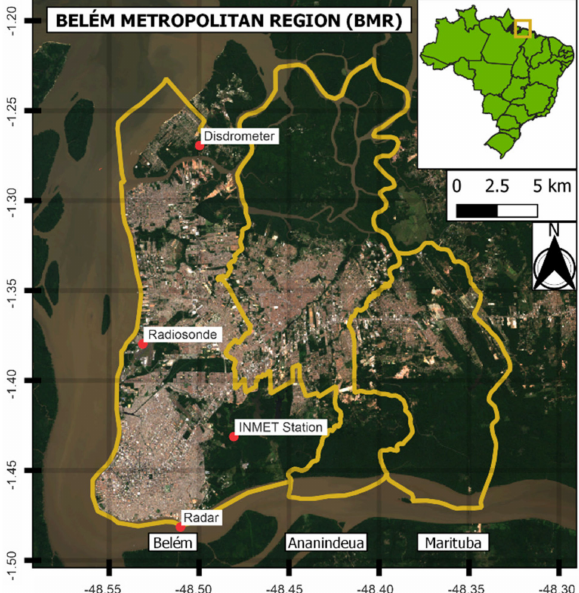
Figure 1. Satellite image from Landsat 8 of the Bel é m Metropolitan Region (BMR) focused on the main urbanized area of Bel é m, Ananindeua, and Marituba (yellow contour). The red dots mark the location of the instruments used: Radiosonde ( − 1.38 ◦ and − 48.48 ◦ ), the INMET surface station ( − 1.43 ◦ and − 48.43 ◦ ), the Radar ( − 1.48 ◦ and − 48.46 ◦ ) and Chuja Project Disdrometer ( − 1.27 ◦ and − 48.46 ◦ ).